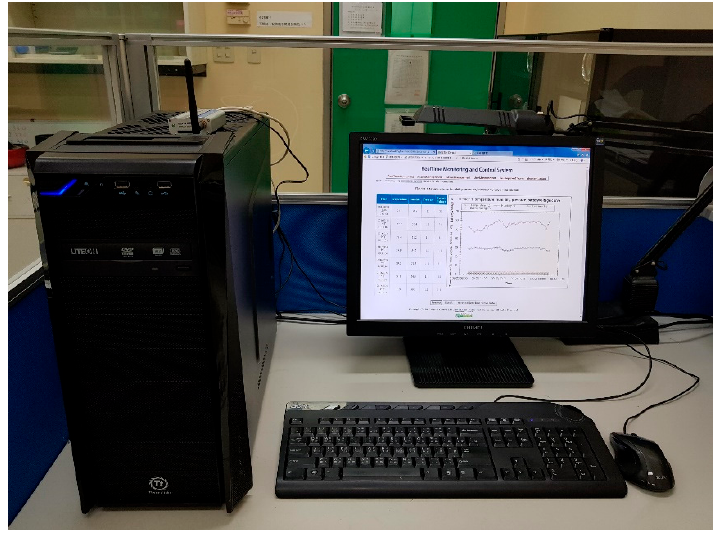
Figure 11. WSN monitoring system server.